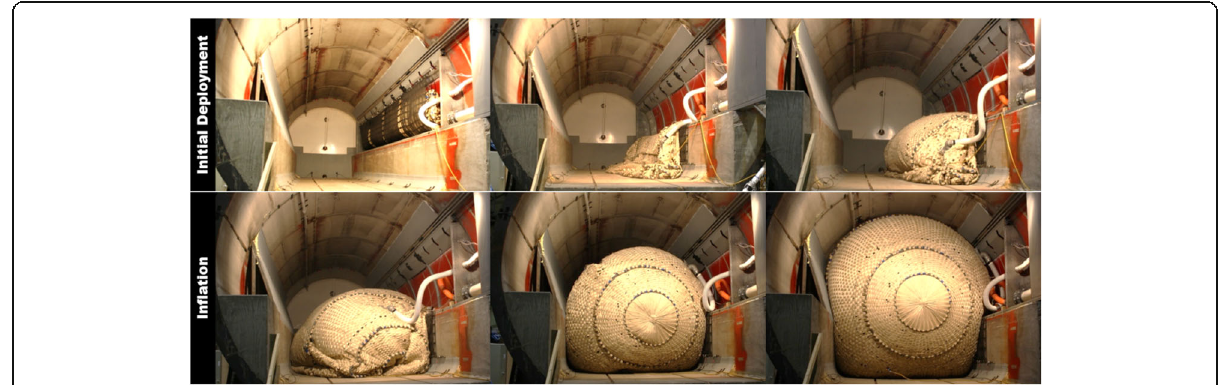
Fig. 8 Phase 2b, full-scale testing, and three-layer Vectran plug. Deployment and low-pressure air inflation for the initial positioning of the plug before flooding simulation [44,